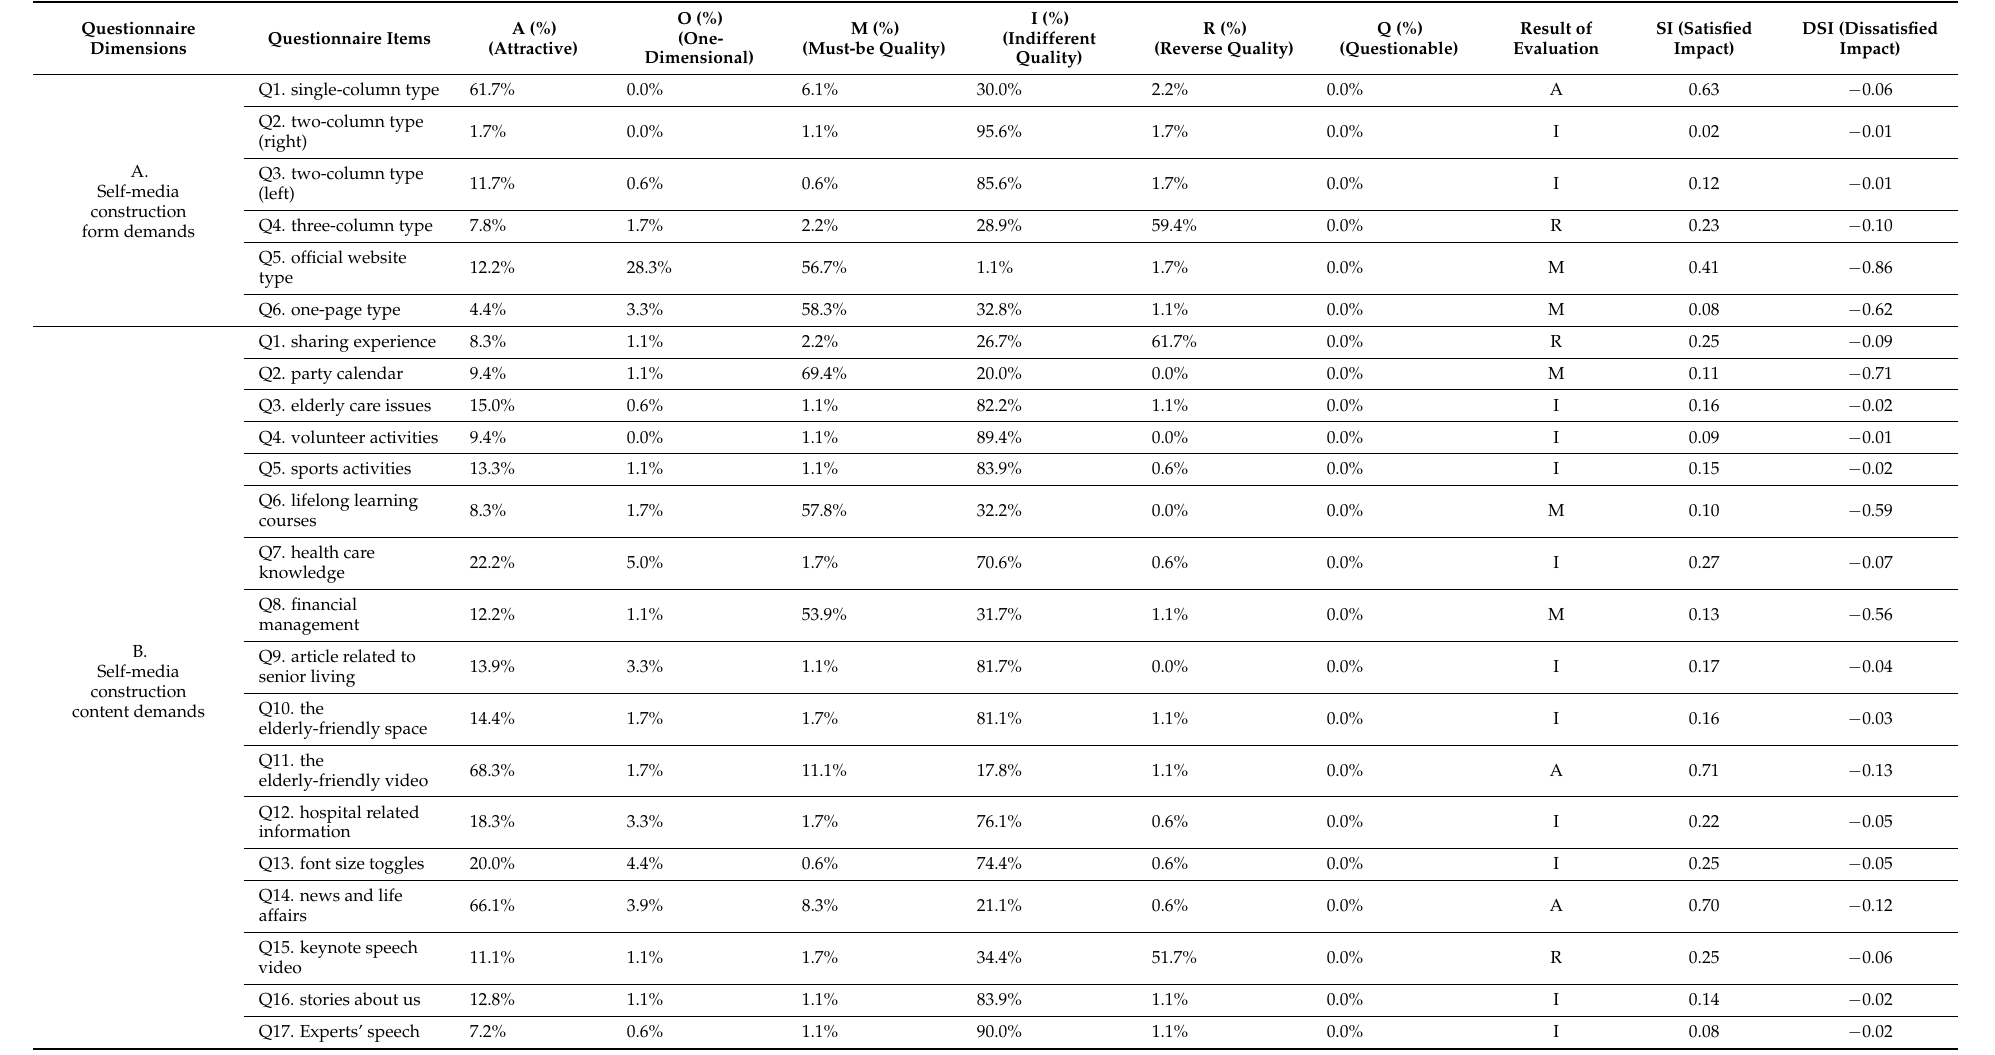
Table 4. The evaluation results of the Kano model